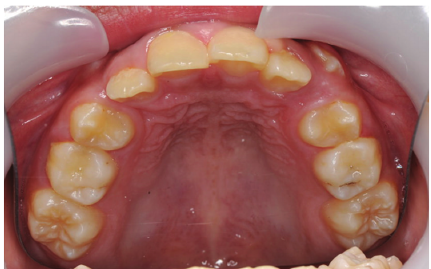
Figure 1: Anterior occlusal photograph of dentition.